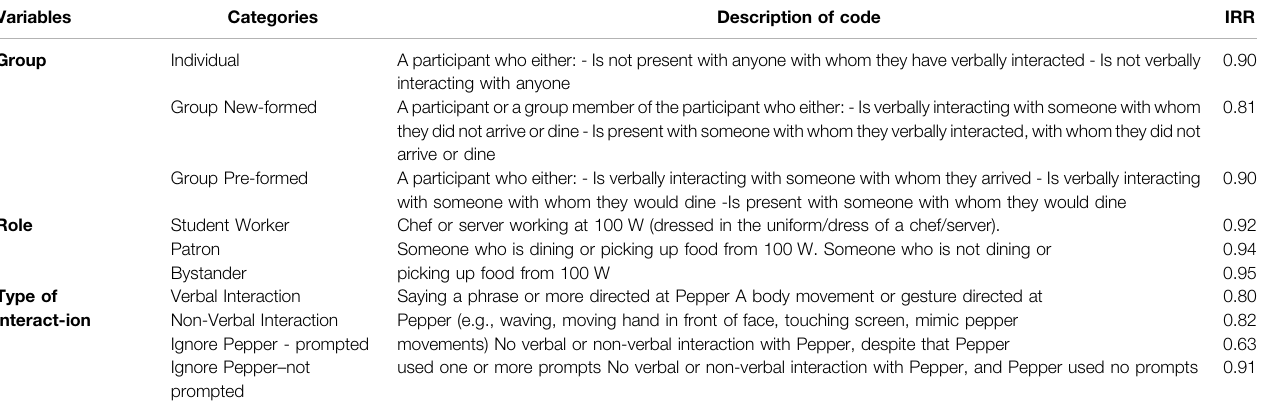
TABLE 1 | A description of all variable de fi nitions used when coding the video feed and inter-rater reliability